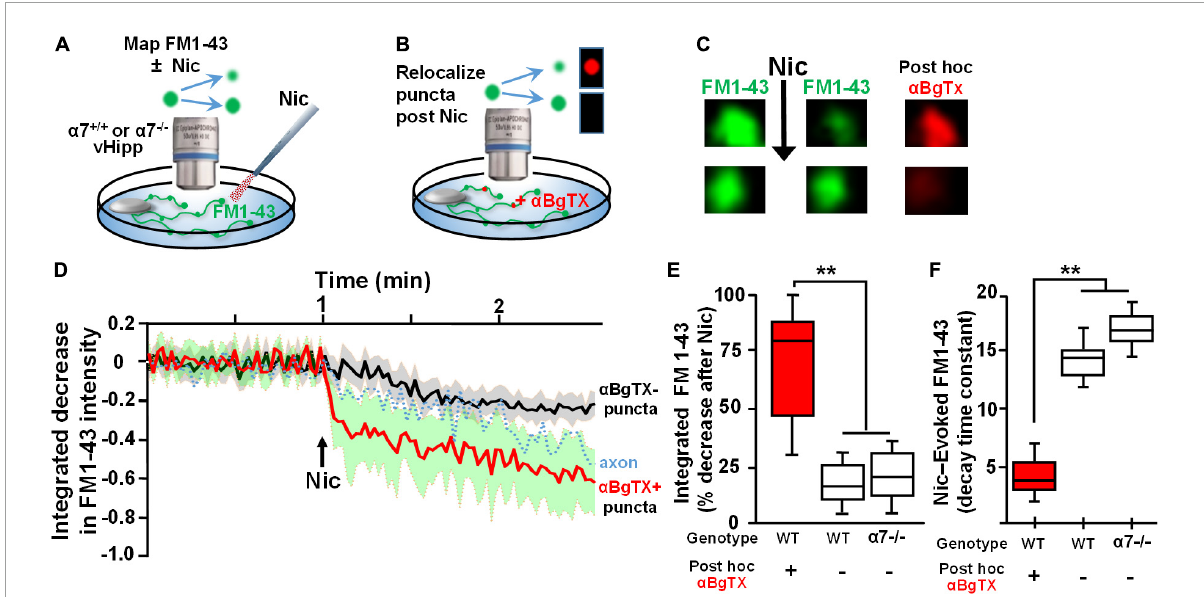
FIGURE2 Re-localization of α 7* nAChRs at individual puncta along ventral hippocampal axons following nicotine-induced FM1-43 de-staining. (A,B) Schematics of the experimental configurations (see Figure 1 legend for illustrative details). (A) vHipp from individual α 7+/+ or α 7–/– mice were plated as thinned micro-explants and were loaded with FM1-43, as described in Section “Materials and methods.” The dynamics of nicotine-induced release were assayed as FM1-43 de-staining along vHipp axons. (B) After recording the effects of nicotine (1 µ M, 1 min)-induced FM1-43 de-staining, the vHipp axons were labeled for surface α 7* nAChRs with α BgTx–Alexa 594. Individual FM1-43 “puncta,” including both those that had and those that had not previously shown nicotine-induced FM1-43 de-staining were re-localized after α BgTx–Alexa 594 labeling. (C) Representative micrographs of sample puncta, one where nicotine had induced robust de-staining (top) and another where nicotine had little effect on the FM1-43 signal (bottom). Subsequent re-localization of these puncta after α BgTx–Alexa 594 labeling, revealed co-localization of α BgTx at sites that had shown strong nicotine-induced FM1-43 de-staining (top), in contrast at sites with little or no α BgTx staining, nicotine had little or no effect on the FM1-43 signal (bottom). (D) Pooled traces of the time course of FM1-43 de-staining in response to nicotine for individual puncta, subsequently re-localized as α BgTx positive (red) vs. α BgTx negative (black). The 30 individual puncta that were re-localized after recording of FM1-43 destaining and that were found to be α BgTx Alexa 594 positive, are averaged before and after nicotine application (red line, SD: green shading; n = 30, 3; see Table 1 for details). The black line shows the averaged de-staining time course of 20 other FM1-143 sites that lacked post hoc α BgTx–Alexa 594 co-labeling ( n = 20,3). The dashed trace in the middle is the time course of nicotine-induced FM1-43 de-staining including all the puncta along a vHipp axon (i.e., including both those with and without post hoc α BgTx–Alexa 594 co-labeling). (E) Box plots of pooled data of the decrease in FM1-43 staining in α 7+/+ v Hipp axons ( n = 60 FM1-43 puncta; three separate experiments; n = 60;3) with post hoc surface α BgTx–Alexa 594 labeling and in α 7–/– vHipp axons ( n = 46; 4). Puncta where nicotine elicited robust de-staining of FM1-43 corresponded to sites of positive post hoc staining for surface α BgTx–Alexa 594, consistent with local expression of α 7* nAChRs ( > 80% decrease). In contrast, weak de-staining of FM1-43 at distinct sites, even along the same axons, was comparable to the partial de-staining seen along α 7–/– vHipp axons and were not co-localized with post hoc labeling for